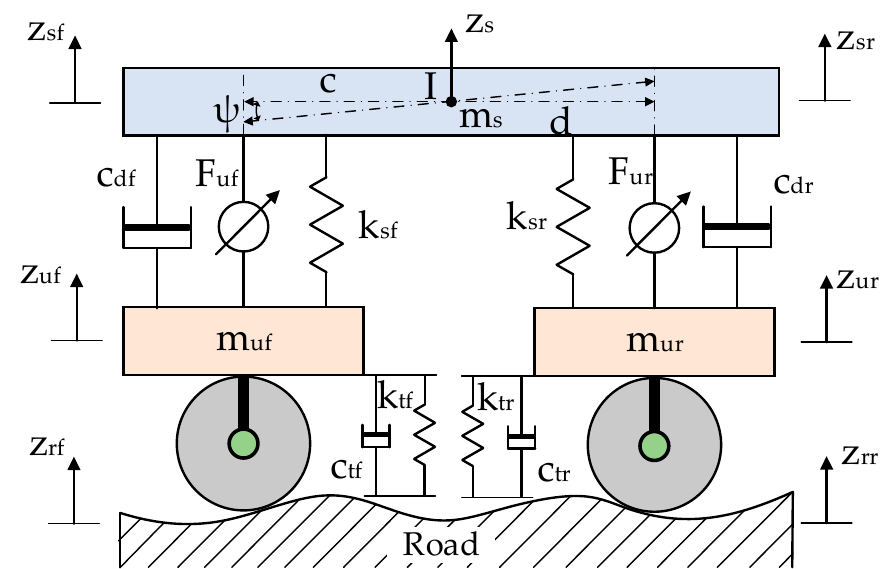
Figure 1. Half car active suspension model.